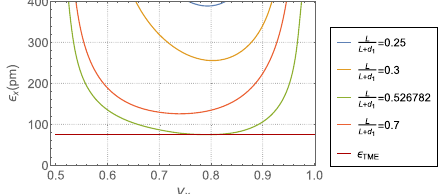
FIG. 12. Normalized to β x ¼ 15 m, β y ¼ 5 m dynamic aper- tures of mTME (left) and TME (right).